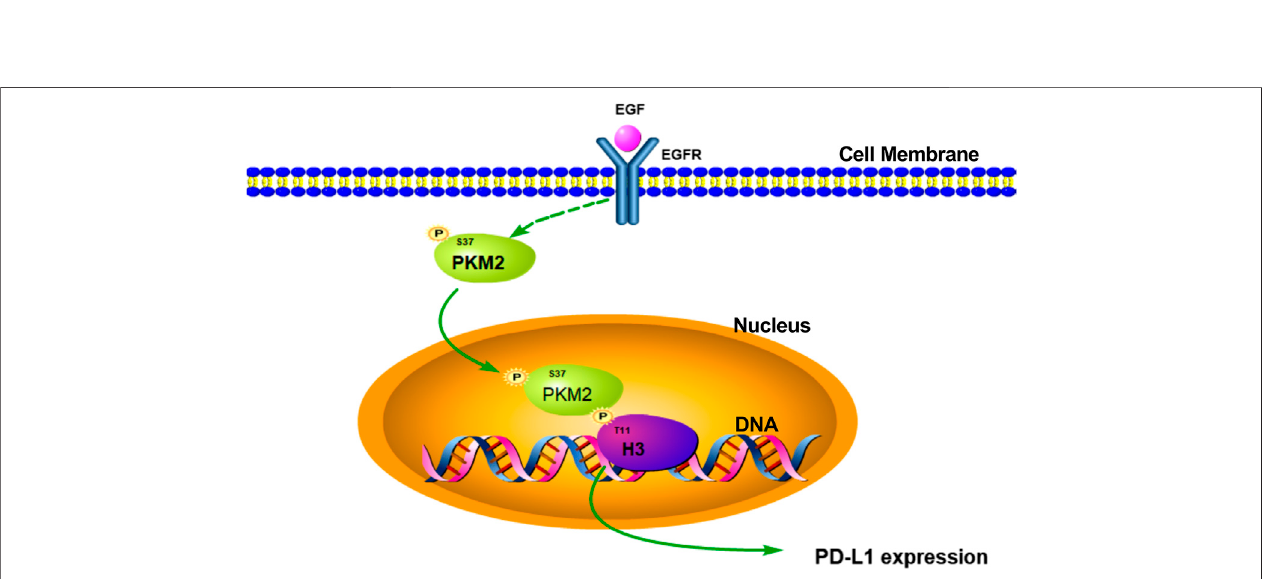
FIGURE 7 | Schematic representation of the activation of EGF induced PD-L1 transcription in hepatocellular carcinoma cells. EGF stimulation induced PKM2 phosphorylationatSer 37 site.Then,thephosphorylatedPKM2translocatesintothenucleustophosphorylatehistoneH3atThr 11 ,leadingtoPD-L1transcriptioninHCC.